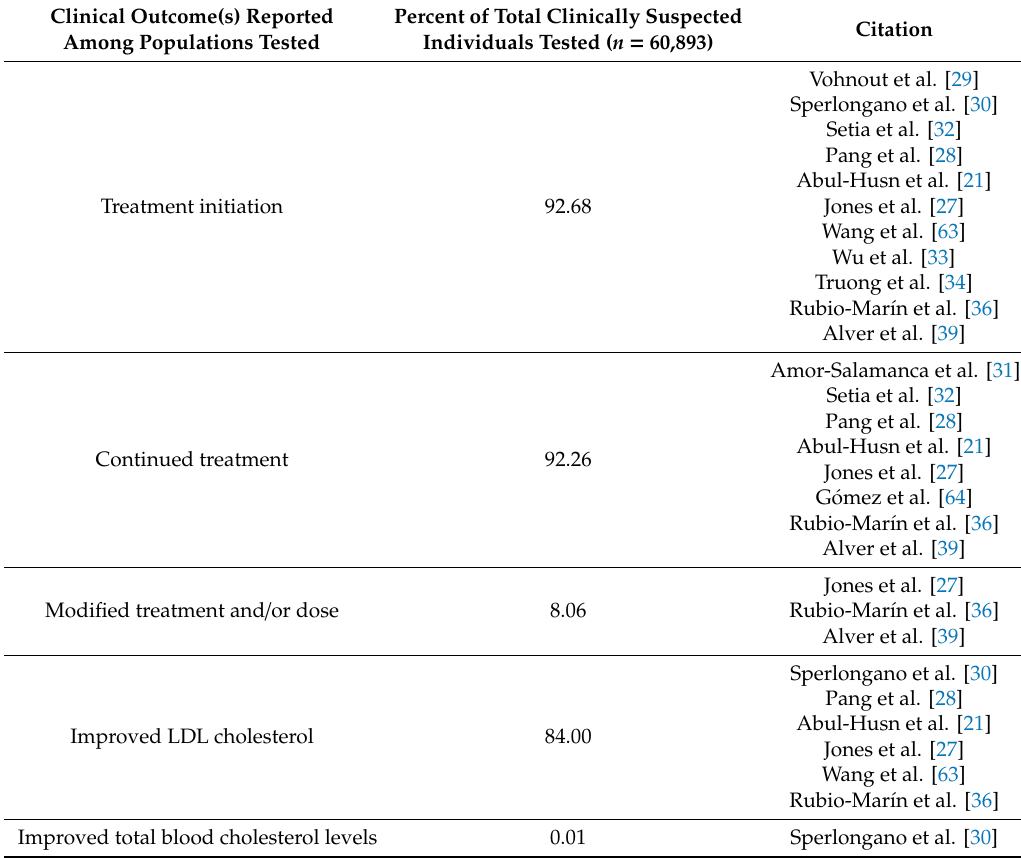
Table A2. Summary of Clinical Outcomes Reported Per Study.